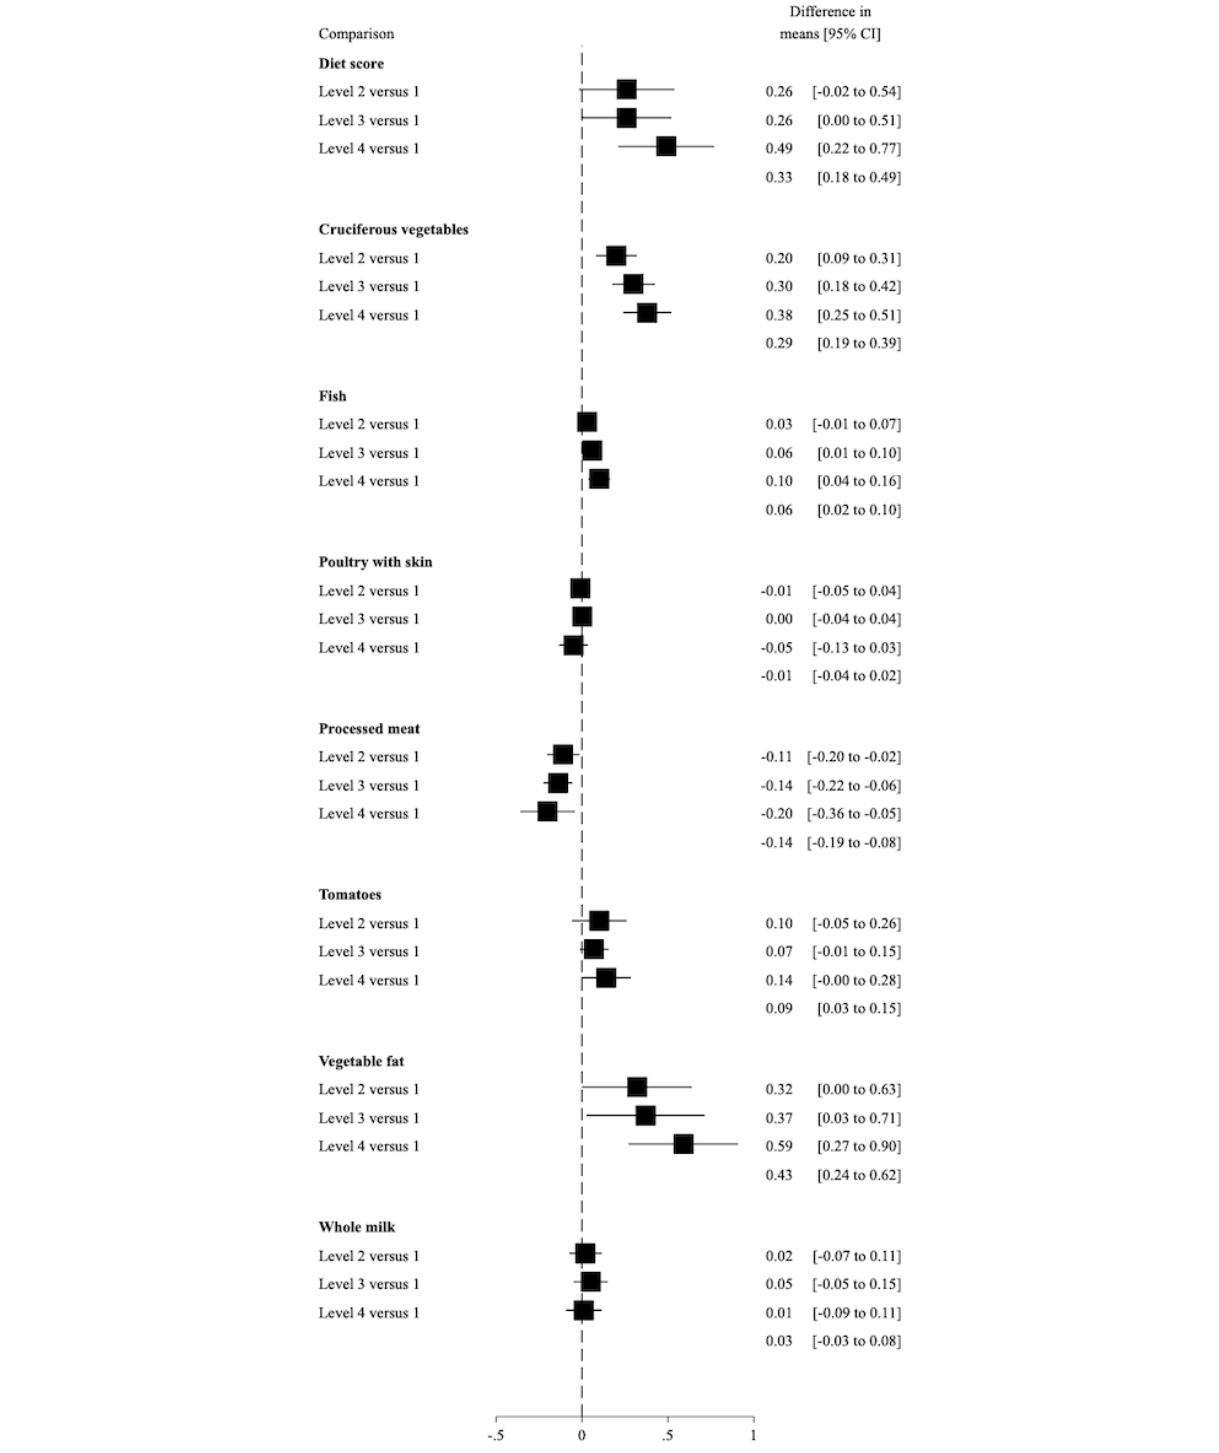
Figure 3. Differences in mean change in an overall diet score (range 0-14) and servings per day of diet items from baseline to 3 months, comparing intervention levels 2 to 4 with level 1. A higher score for the overall diet score indicates healthier diet behaviors. The intervention aimed to increase intake of cruciferous vegetables, fish, tomatoes, and vegetable fat and decrease intake of poultry with skin, processed meat, and whole milk. These secondary analyses included the 146 men with complete data on diet behaviors at 0 and 3